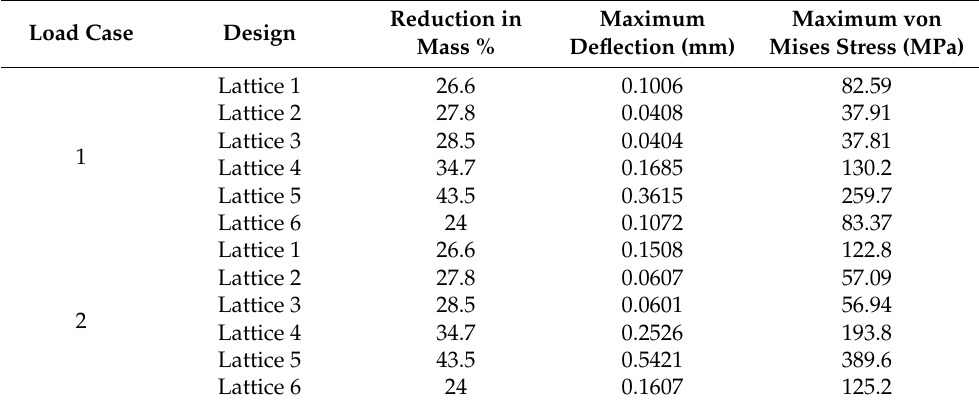
Table 3. Lattice structure performance in terms of maximum deflection, reduction in mass, and maximum von Mises stress when subjected to load cases 1 and 2.